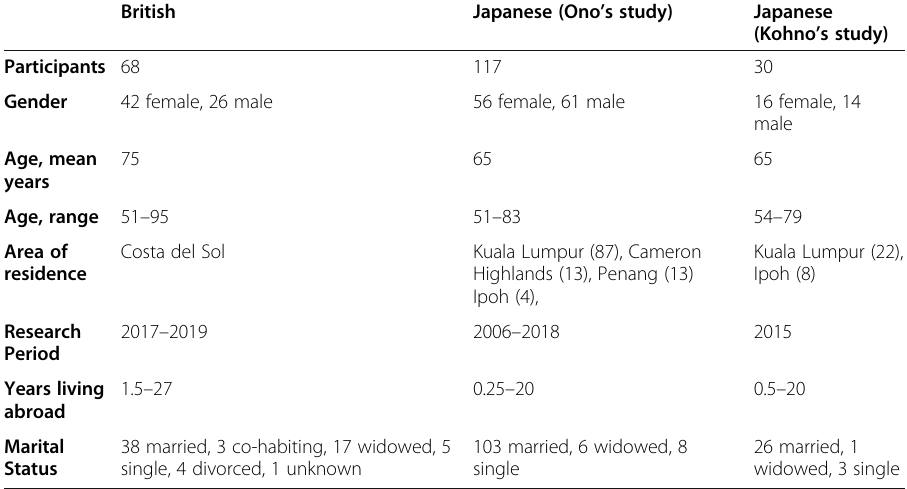
Table 1 Summary of